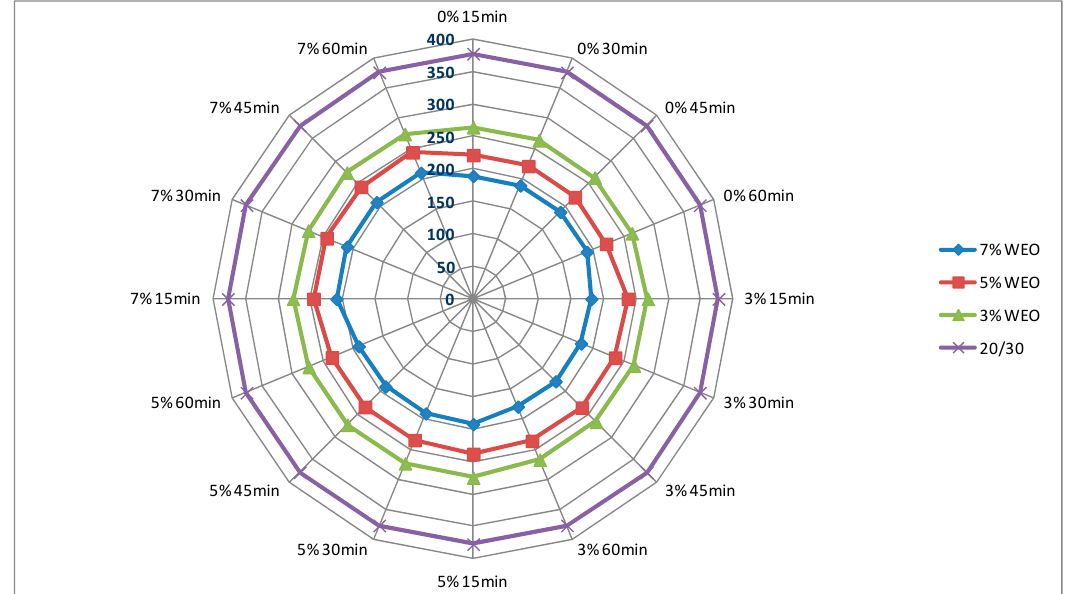
Figure 5. The results of dynamic viscosity tests for the 20/30 asphalt with the addition of WEO and clinoptilolite zeolite measured at 160 °C (mPa·s).